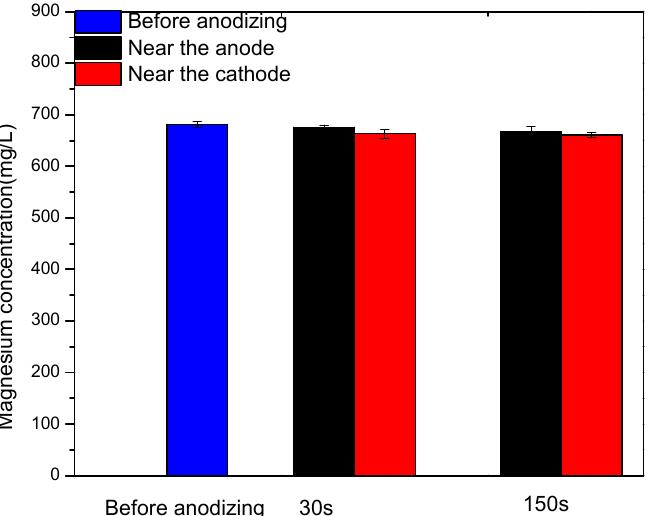
Figure 6. The magnesium concentration in the solution of the Mg-10-KOH-8 system before MAO treatment and near the anode and the cathode after MAO treatment for 30 s and 150 s.